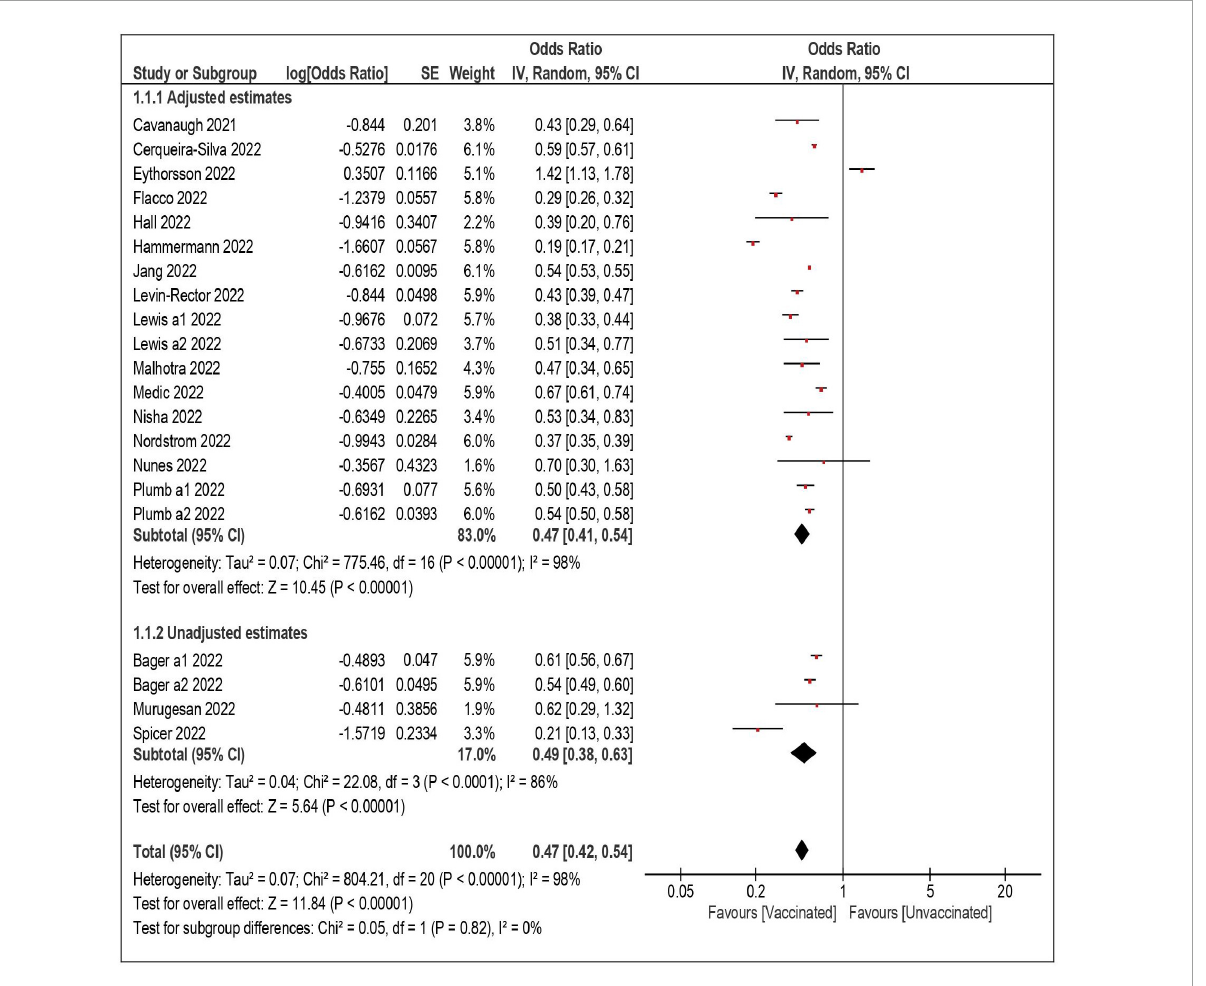
FIGURE1 Risk of SARS-CoV-2 reinfection among vaccinated vs. unvaccinated